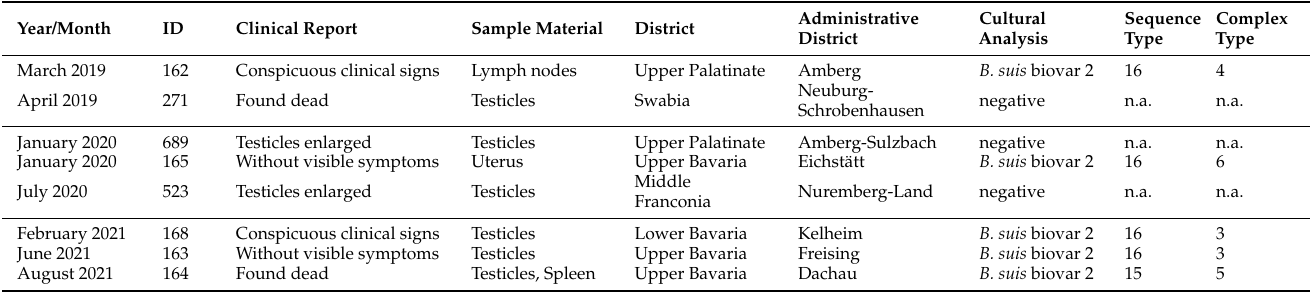
Table 2. Results on the Brucella PCR-positive wild boars in Bavaria from 2019 to